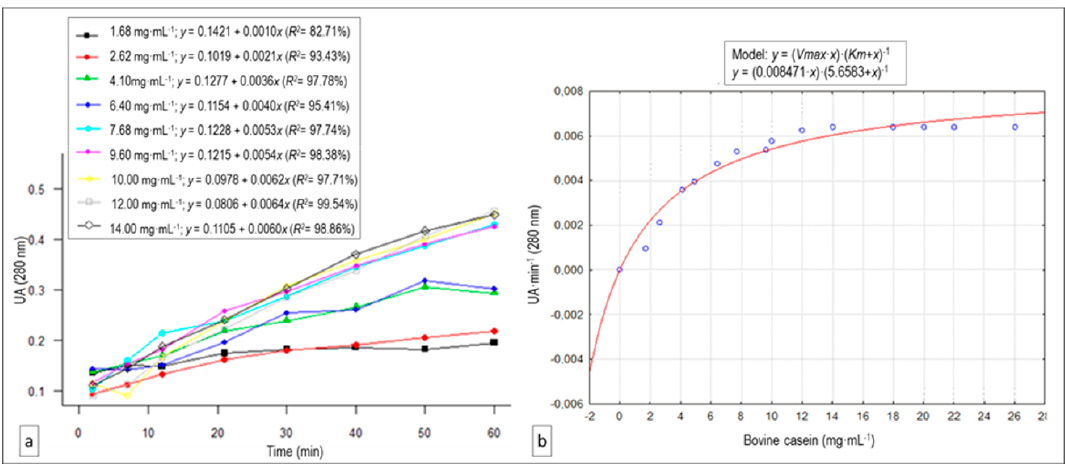
Figure 4. ( a ) Variation of absorbance (which correlates with proteolytic activity) with reaction time for each of the casein concentrations tested, as well as their regression equations and determination coefficients ( R 2 ), for the proteolytic activity linear trend of the C. scolymus L. extract on bovine casein. ( b ) Michaelis–Menten saturation curve for the enzyme reaction, showing the relationship between the bovine casein concentration and proteolysis rate (V max and K m estimation).